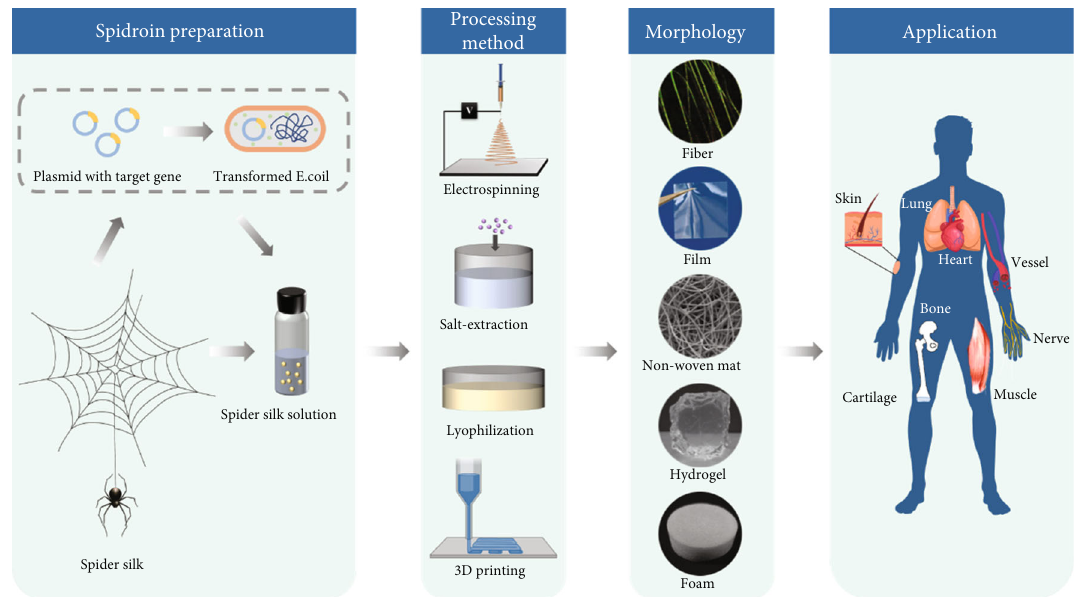
Figure 2: Schematic diagram of sca ff old preparation using recombinant spidroins manufactured by transformed E. coli and their applications in the tissue engineering area. Reproduced from S. Salehi et al., 2020, under the Creative Commons Attribution